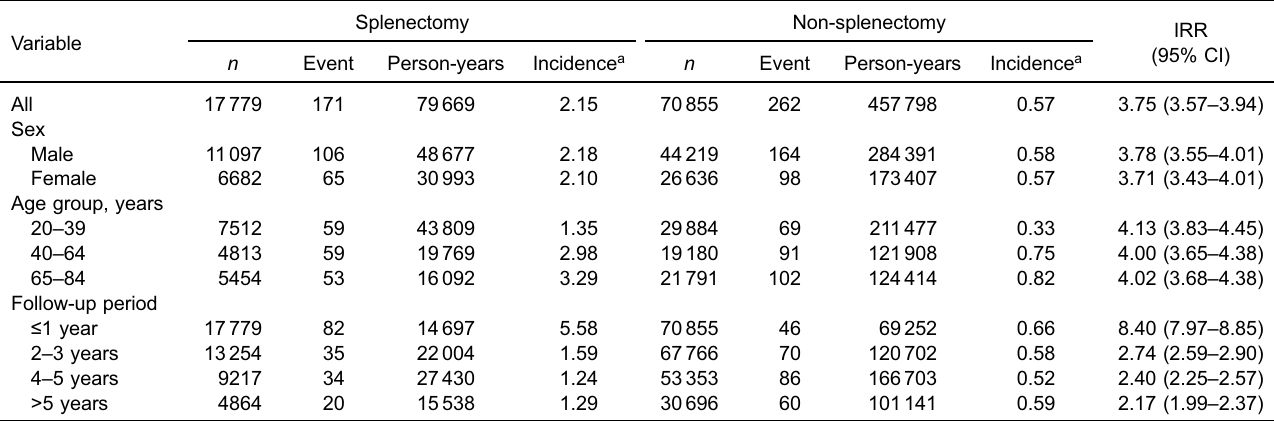
Table 2. Incidence density of pyogenic liver abscess strati fi ed by sex, age and follow-up period between splenectomy group and non-splenectomy group Variable